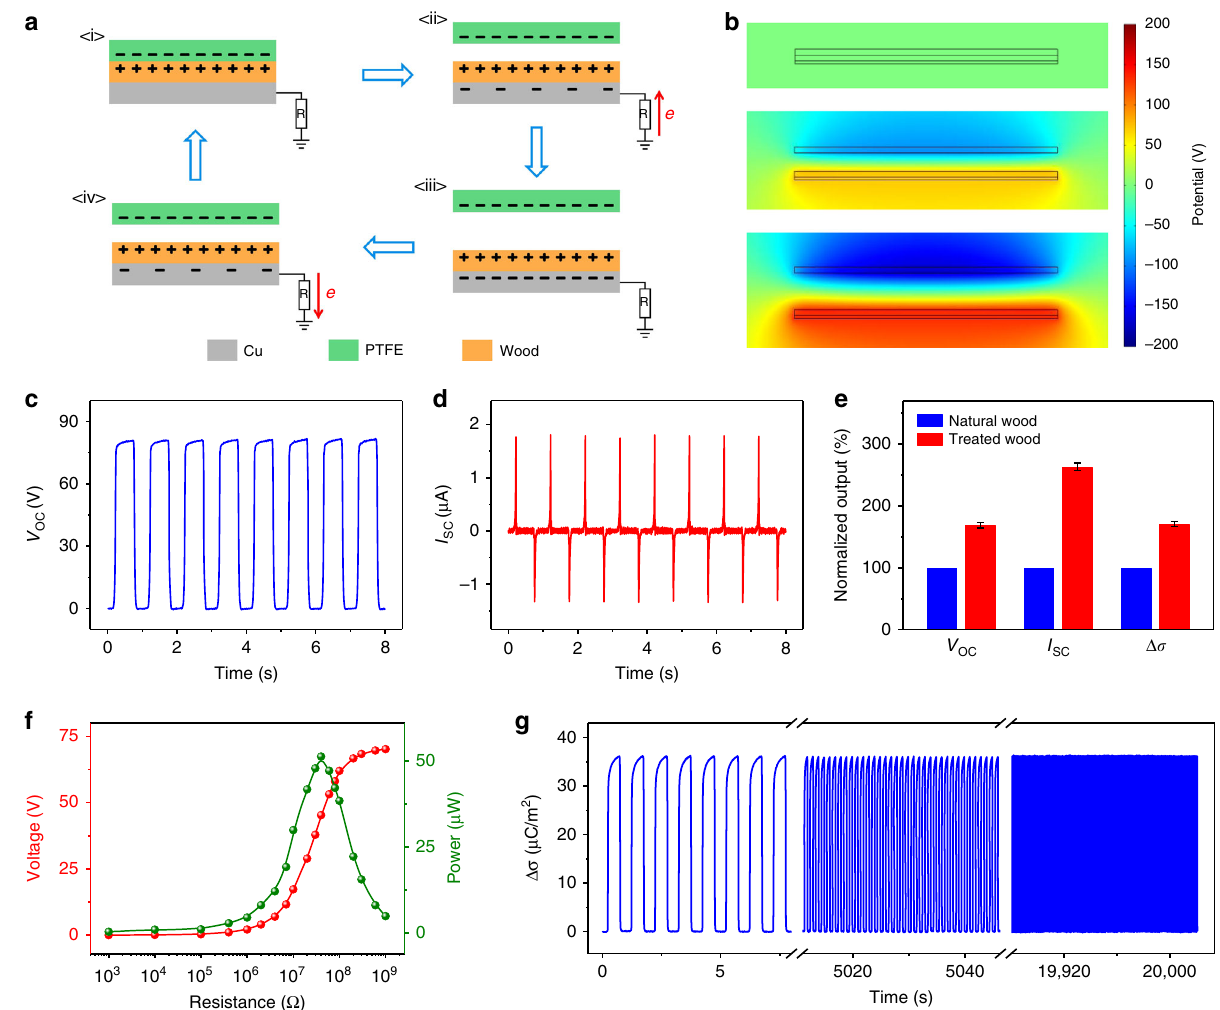
Fig. 3 Working mechanism and output performance of W-TENG in single-electrode mode. a Schematics of the operating principle for the W-TENG. b Potential simulation by COMSOL to elucidate the working principle. c , d Open-circuit voltage, short-circuit current of the W-TENG based on treated wood. e Comparison of the output performance between W-TENGs based on natural wood and treated wood. f Dependence of the output voltage and peak power of the W-TENG based on treated wood on the resistance of external load. g Stability and robustness measurement of the W-TENG, where the transferred charge density was recorded for over 20,000 cycles at a frequency of 1